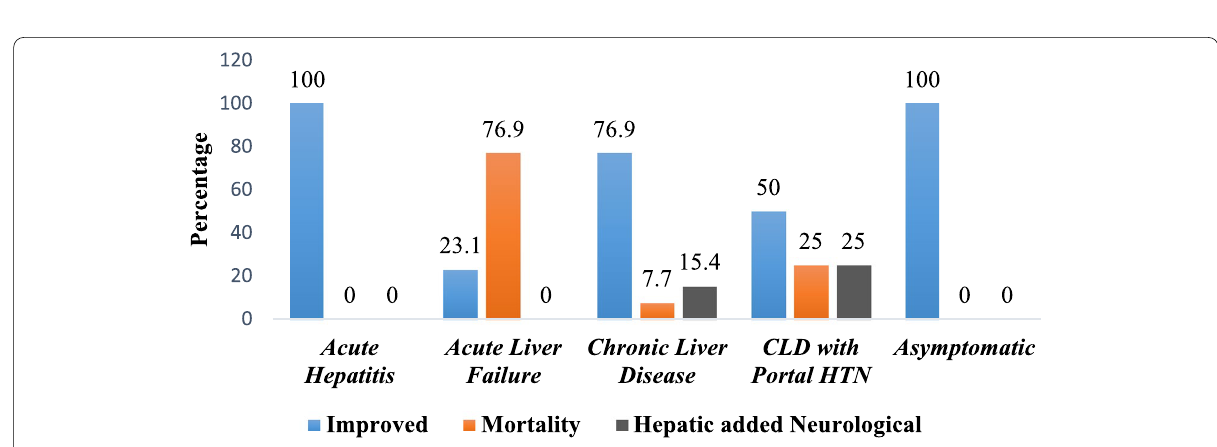
Fig. 6 Outcome of WD with different hepatic presentation ( n